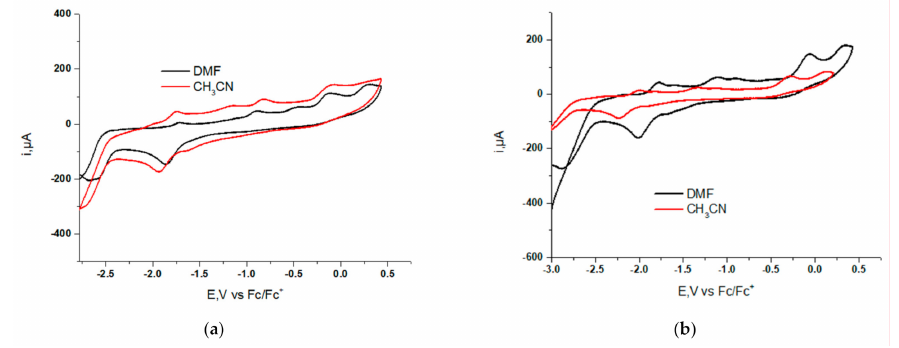
Figure 4. Cyclic voltammograms of ( a ) 1 (10 − 3 M) in DMF ( black ) and in CH 3 CN ( red ), ( b ) 2 (10 − 3 M) in DMF ( black ) and in CH 3 CN ( red ), 0.1 M n-Bu 4 NPF 6 , a glassy carbon as a working electrode, an Ag/AgCl as a reference electrode and a Pt wire as a counter electrode. The scan rate was 100